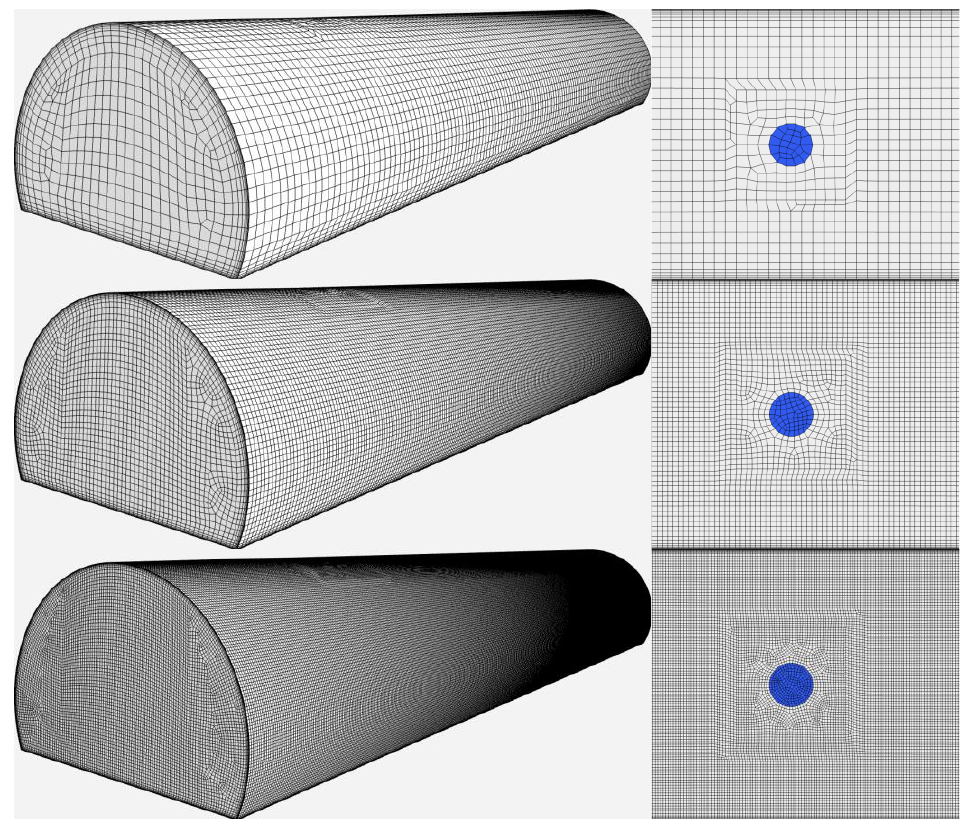
Figure 5. The coarse, medium, and fine meshes in the top, middle, and bottom panels, respectively, with a bottom-up view of the mesh around the pool shown on the right.